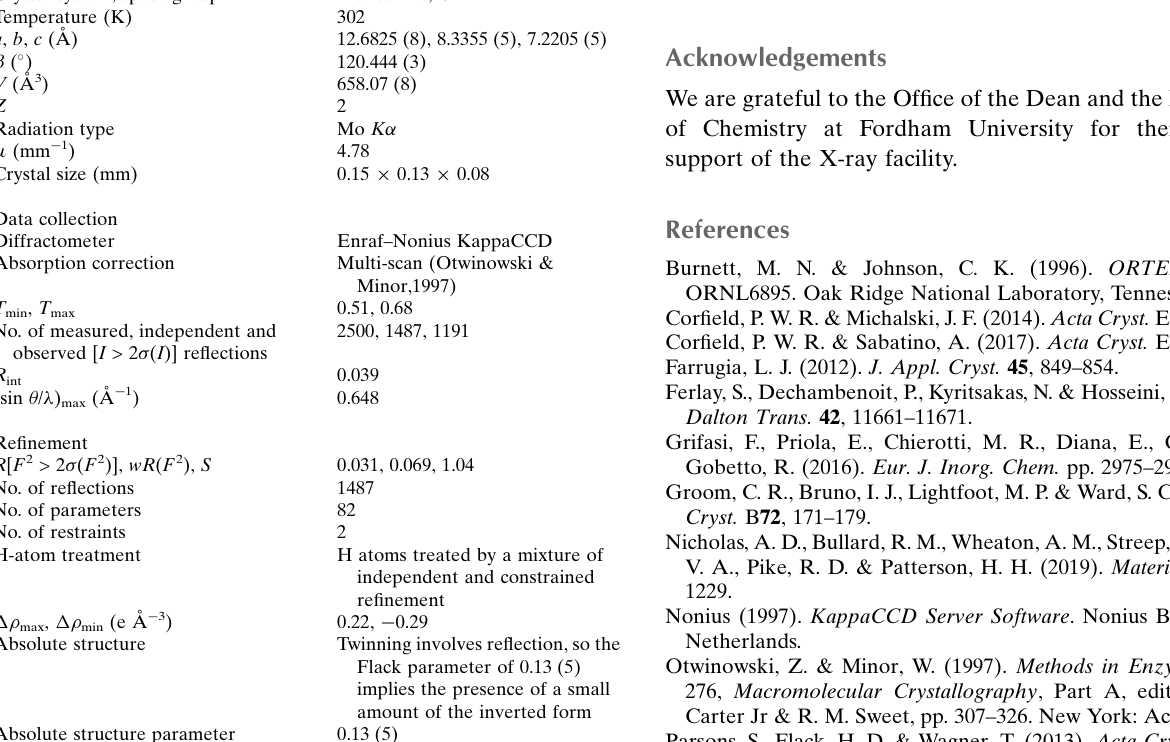
Crystal data Chemical